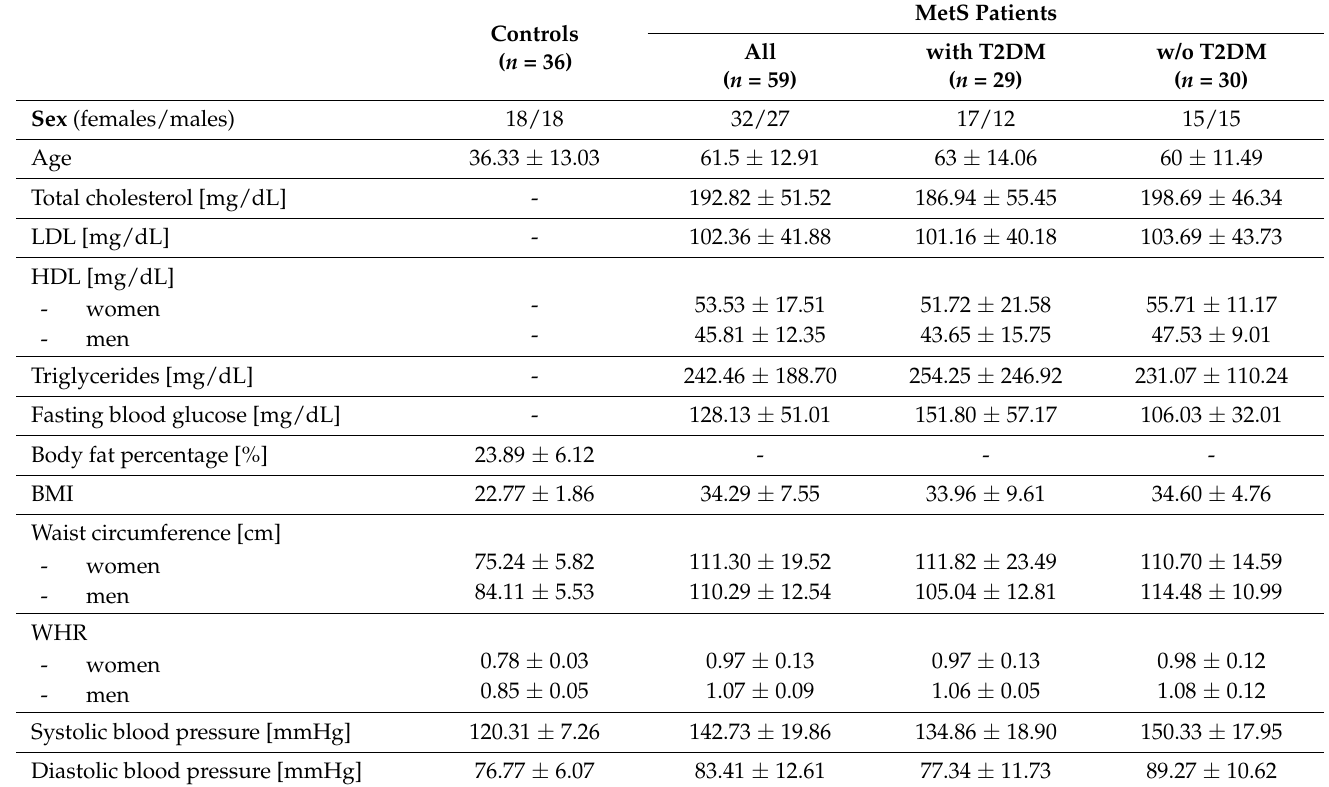
Table 1. Patient and control